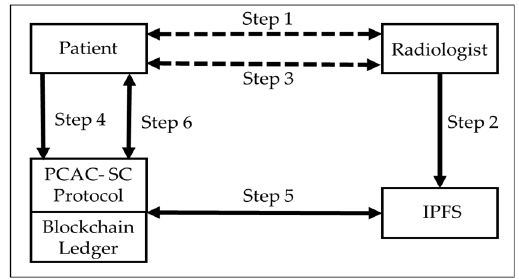
Figure 3. Interaction model of the PCIM system.